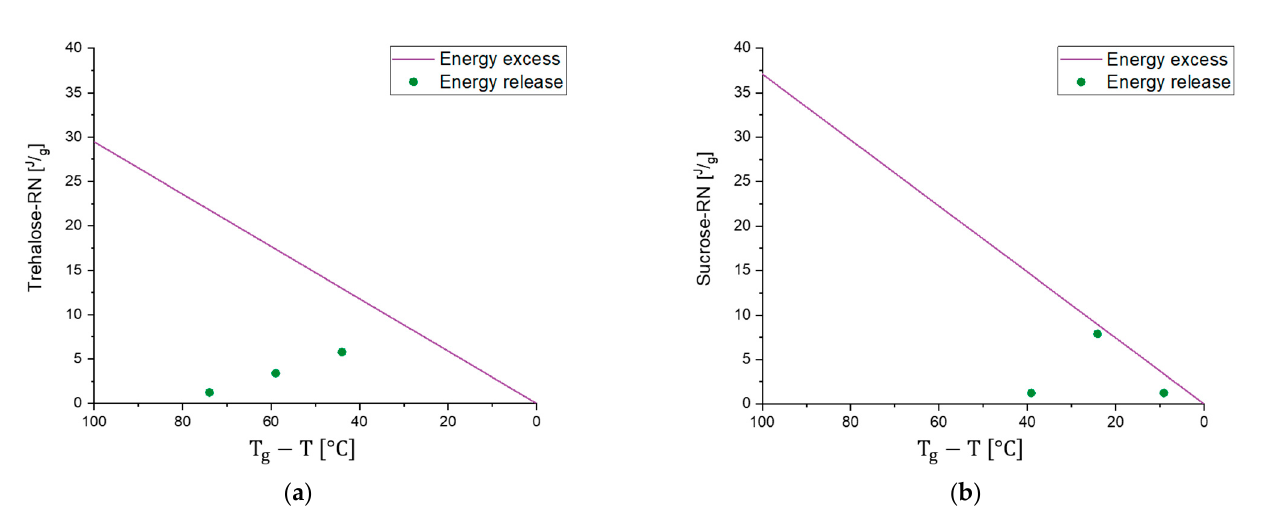
Figure 10. Model of Figure 5 applied to the samples Trehalose-RN ( a ) and Sucrose-RN ( b ). The purple rectangles show the theoretical maximum of energy excess that the respective sample possesses at a temperature of T g − T calculated with Formula (3). The green dots show the measured relaxation that occurs in the time scale of the experiment.